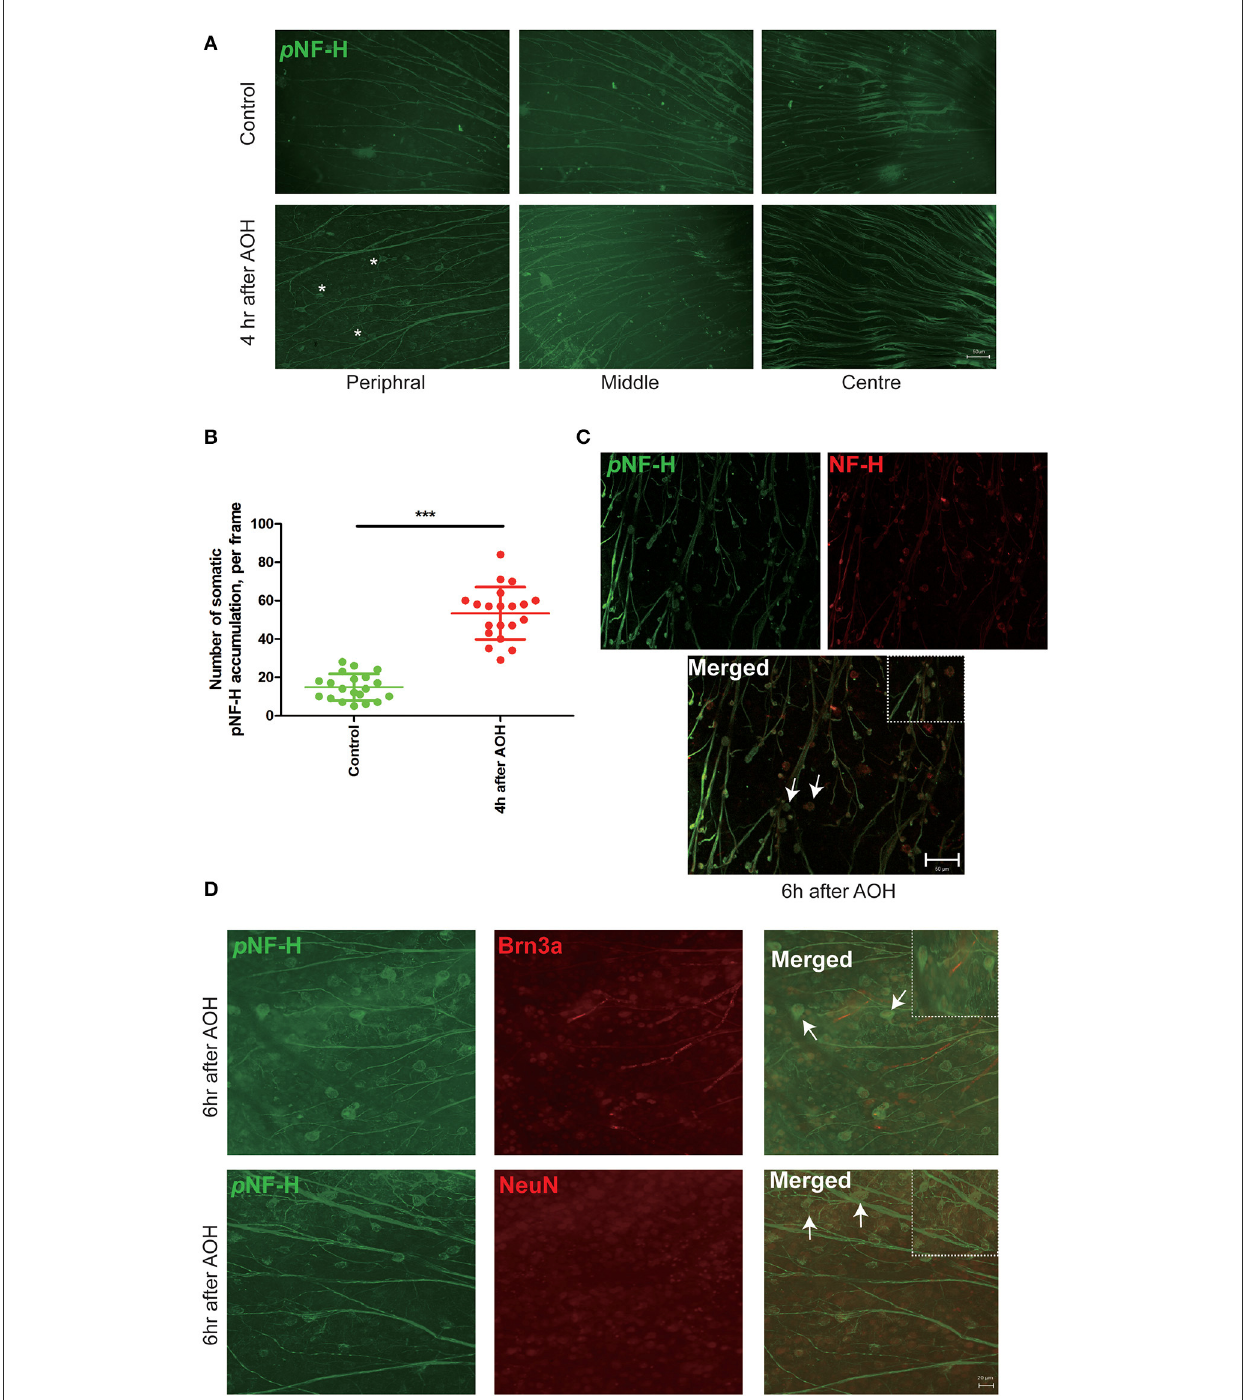
FIGURE4 NF-H and its phosphoforms accumulated in the soma of peripheral RGCs after AOH. (A) Immunofluorescence of the pNF-H marker, SMI31, in the retinal wholemount 4h after AOH; retinal wholemount was observed from peripheral to central regions. Asterisk indicates pNF-H accumulation in the peripheral retina. Scale bars: 50 µ m. (B) Quantification of pNF-H accumulation in the peripheral retina. The data are presented as a scatter diagram. Mean ± SD is shown, n = 5 for each group, *** P < 0.001. (C) Immunofluorescence of pNF-H and NF-H in the retinal wholemount of AOH after 6h. Micrographs show that most of the pNF-H accumulations were overlapped with NF-H, with arrows indicating examples of co-expression, and the high magnification image is also shown (top right of the third picture), Scale bars: 50 µ m. (D) Immunofluorescence of pNF-H and the RGC markers Brn3a and NeuN in the retinal wholemount of AOH after 6h. pNF-H accumulations were highly overlapped with an RGC marker, and the high magnification images are also shown (top right of the third picture and sixth picture). Scale bars: 20 µ